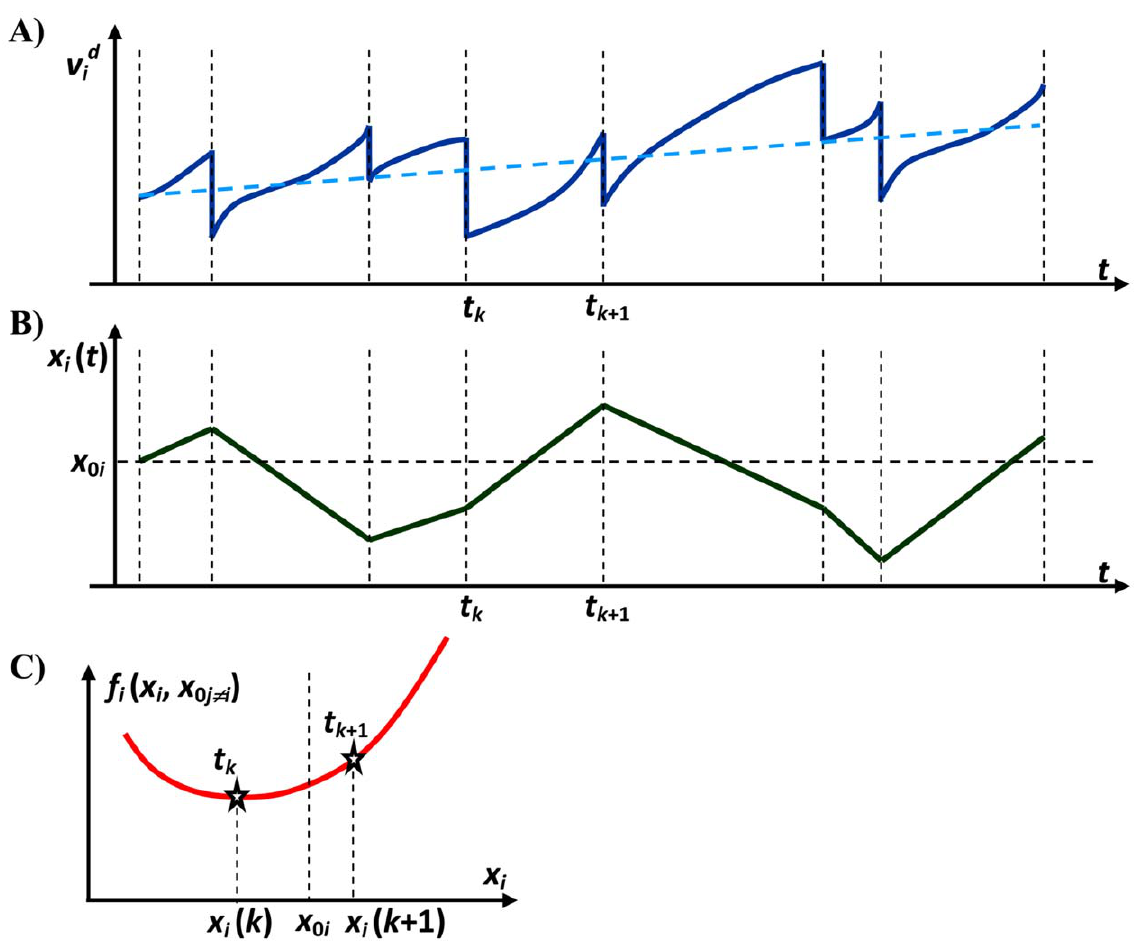
Figure 2. A schematic presentation of the deterministic velocity andlocation of a particle along i th direction. Expectation value of deterministic velocity (dashedbluelineinpanel A) varies graduallyover time. Locationvaries linearlybetweenanytwoconsecutivecollisions (panel B). The traveled distance between any two consecutive collisions is sufficiently long that the conservative force (panel C) may not be considered constant along the path.